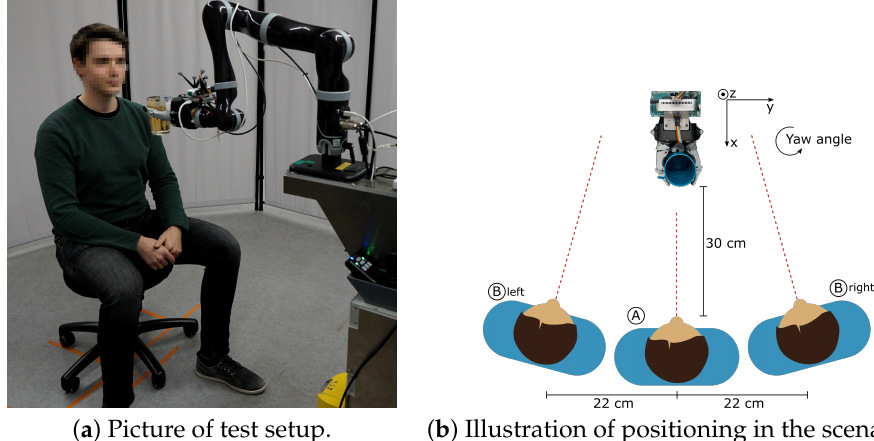
Figure 8. Illustration of the test setup and the position of the robot and subject for the different scenarios. Position A is used in scenario one and two. Position B is used in scenario three. The dashed red lines represent the heading